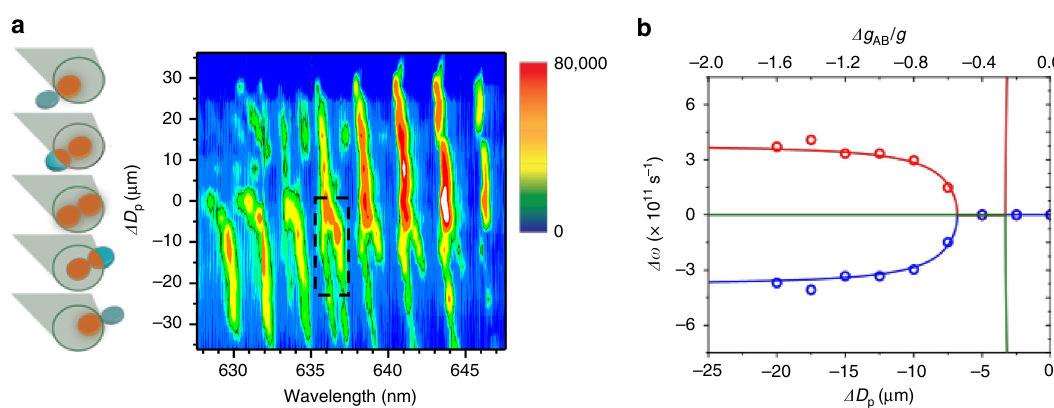
Fig. 3 Laser emission behavior of a microdisk pair under spatial gain variation a False-color contour plot of the emission intensity vs. wavelength and relative distance, Δ D p , between the center of the pair to the center of the beam spot, as the pair is shifted through the pump beam spot, which is schematically illustrated on the left. As the microdisk pair nears the center, the split modes merge as clearly seen for several mode pairs in the range of 635 – 645nm. b Mode splitting in the defected microdisk vs. Δ D p as obtained from the dashed-boxed region in a . The solid lines are eigenvalue dynamics as a function of the gain differential Δ g AB between the coupled microdisks in a three-mode Hamiltonian that shows coalescence of the intra-cavity modes in the defected microdisk due to the gain variation between the coupled microdisks. The model parameters are κ = 3.8 × 10 11 s − 1 , γ 23 = 1.2 × 10 12 s − 1 and γ = 0 s − 13